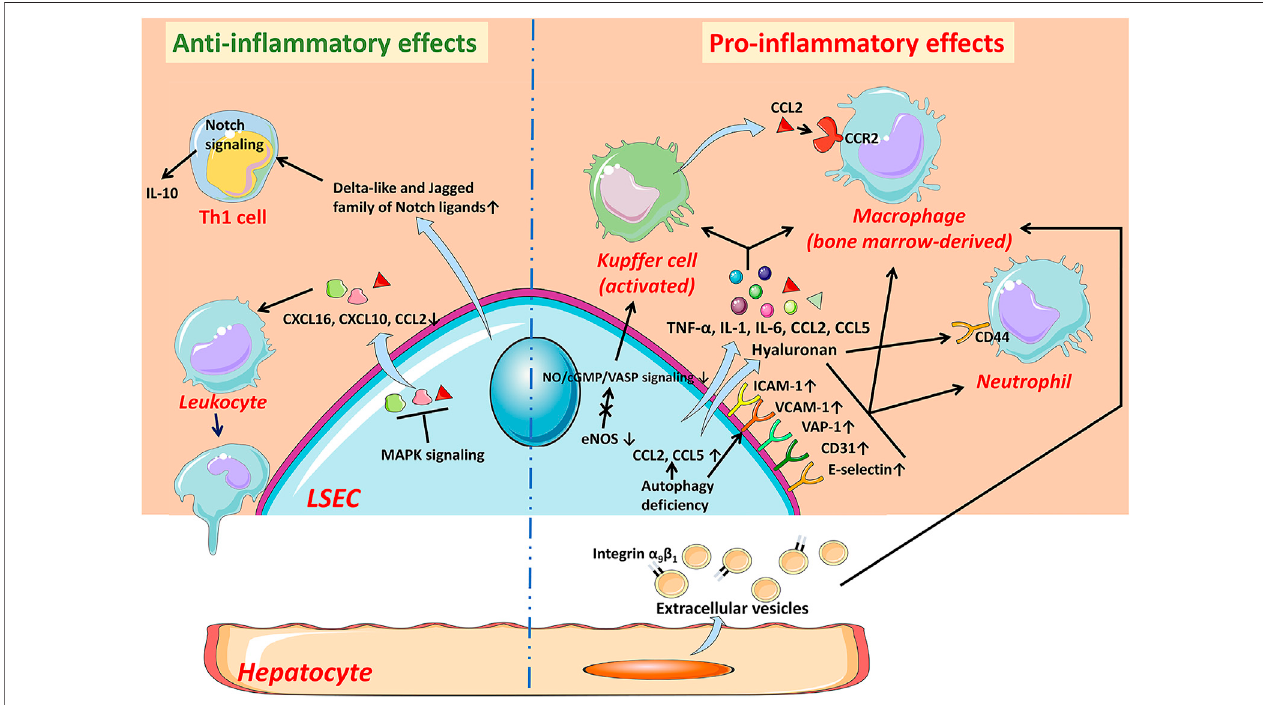
FIGURE 2 | The anti-in fl ammatory and pro-in fl ammatory effects of LSECs in NAFLD. In the early stage of NAFLD, LSECs develop an anti-in fl ammatory phenotype manifested by the decreased expression of chemokines CCL2, CXCL10, and CXCL16 through MAPK signaling-dependent manner. LSECs can also promote the secretion of IL-10 by Th1 cells via releasing Notch ligands to exert anti-in fl ammatory effects. While LSECs characterized as pro-in fl ammatory phenotype, increase expression of adhesion factors including VCAM-1, ICAM-1, E-selectin, CD31, and VAP-1, leading to increased recruitment of leukocytes. The de fi ciency of autophagyalsoleadstoup-regulationofadhesionfactorsandchemokines.Pro-in fl ammatorymediatorsreleasedbyLSECs,suchasTNF- α ,IL-1,andIL-6,alsopromote the progress of in fl ammation. The reduction of NO bioavailability contributes to the activation of KCs and the recruitment of bone marrow-derived macrophages. The hyaluronan densely coated on the surface ofLSECsfacilitates the recruitment ofneutrophils by interactingwith CD44. In addition, hepatocyte-derived EVs contribute to therecruitmentofmacrophagesintothehepaticsinusoids. CCL C-Cmotifchemokineligand, CCR C-Cmotifchemokinereceptor, CXCL C-X-Cmotifchemokineligand, eNOS endothelial nitric oxide synthase, ICAM-1 intercellular adhesion molecule-1, IL interleukin, LSEC liver sinusoidal endothelial cell, NO Nitric oxide, TNF- α tumor necrosis factor- α , VAP-1 vascular adhesion protein-1, VCAM-1 vascular cell adhesion molecule-1.